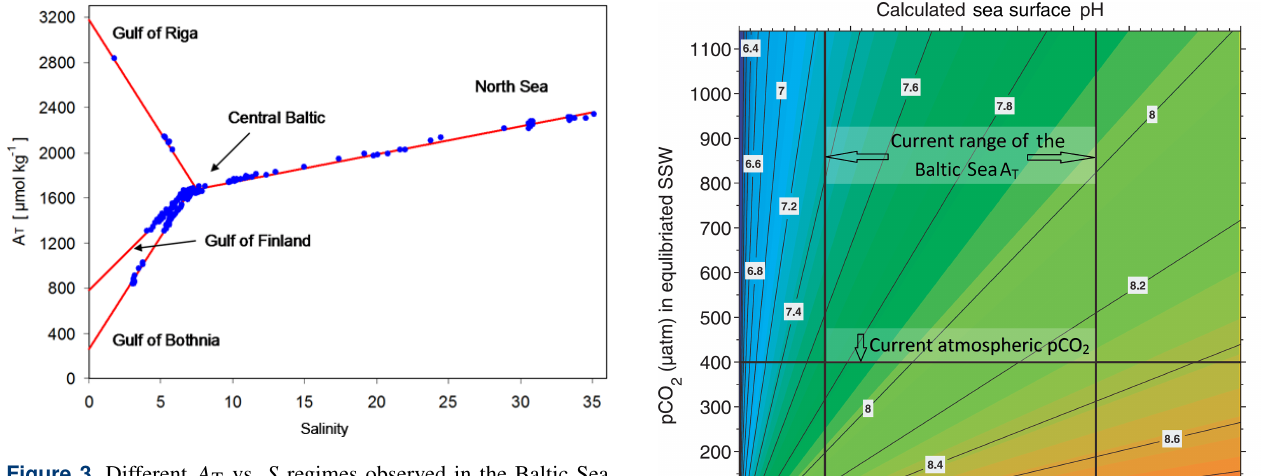
Figure 3. Different A T vs. S regimes observed in the Baltic Sea (modified after Beldowski et al., 2010).